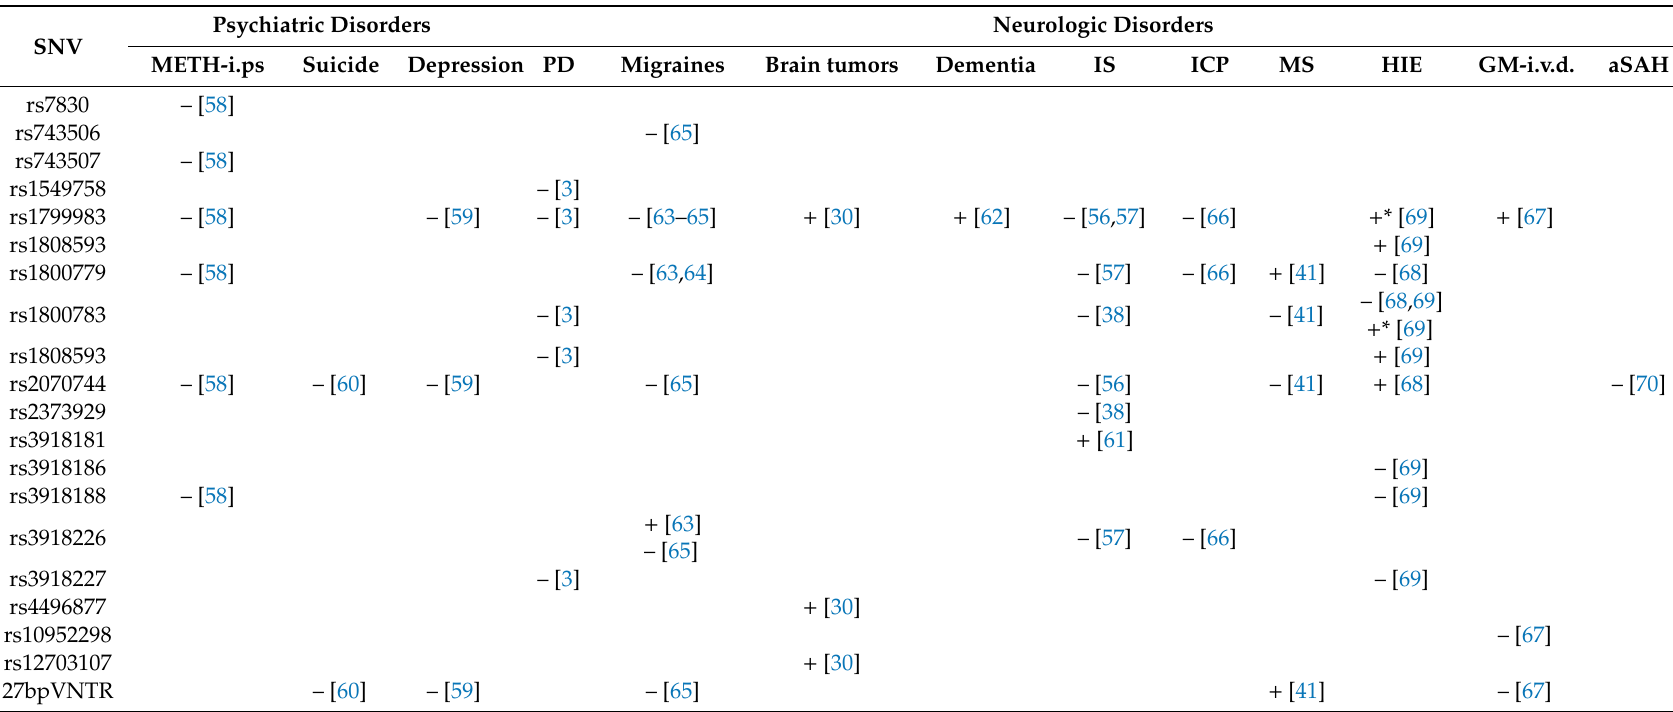
Table 3. Association of NOS3 SNVs with neuropsychiatric disorders.aSAH: Aneurysmal Subarachnoid Hemorrhage, GM-i.v.d.: GM-induced Vestibular Dysfunction, HIE: Hypoxic-Ischemic Encephalopathy, ICP: Infantile Cerebral Palsy.